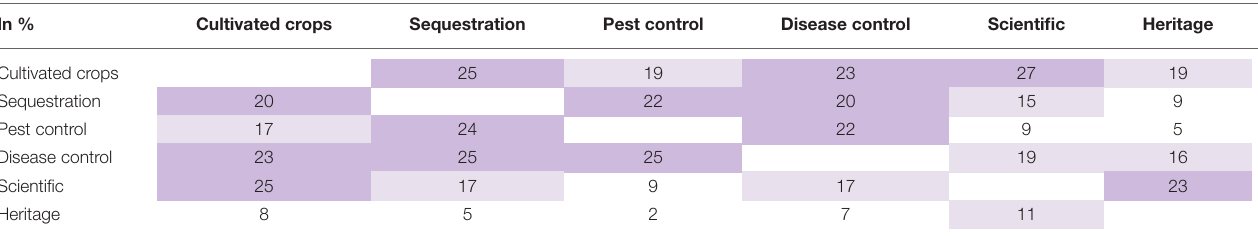
TABLE 3 | Percent overlap between publications across the six key ecosystem service classes we identified in vineyards, with darker shading indicating greater overlap between the two ecosystem service classes. In